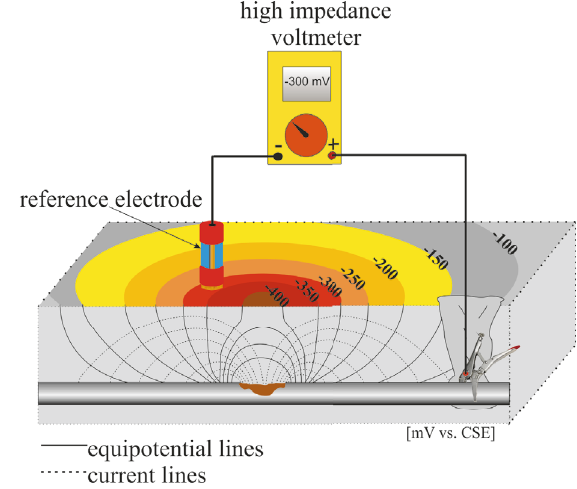
Figure 1: Principle of potential mapping.